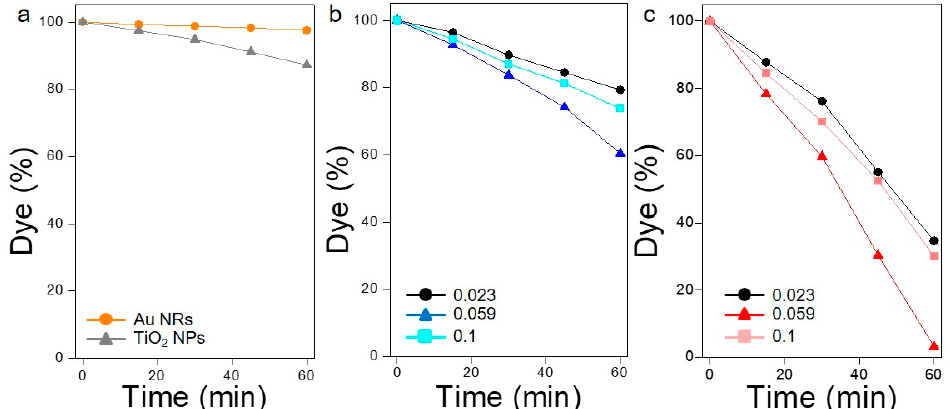
Figure 3. Photodegradation profiles of RhB in the presence of di ff erent photocatalysts: ( a ) reference samples consisting of Ti NWs functionalized with Au NRs (orange circles) or TiO 2 NPs (grey triangles), separately; ( b ) Ti NWs with TiO 2 NPs and spherical Au NPs (Au / TiO 2 molar ratios: 0.023 in black circles, 0.059 in blue triangles and 0.1 in cyan squares); and ( c ) Ti NWs functionalized with TiO 2 NPs and Au NRs (Au / TiO 2 molar ratios: 0.023 in black circles, 0.059 in red triangles and 0.1 in pink